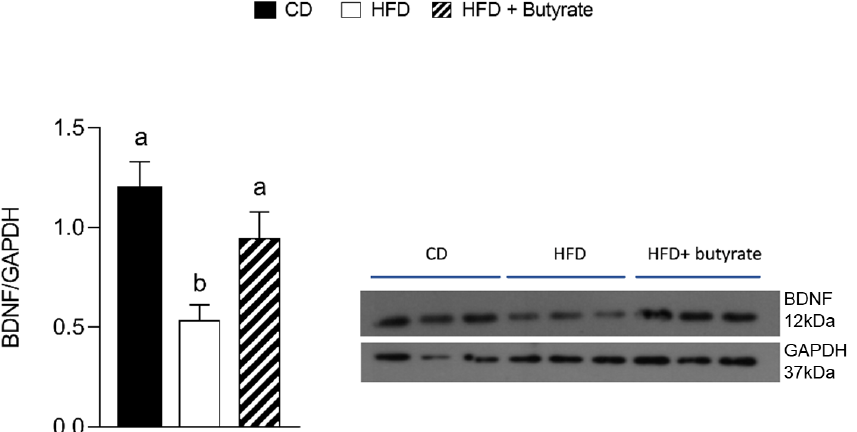
Figure 7. Effects of butyrate treatment on BDNF expression levels in the cerebral cortex of diet- induced obese mice. Expression level of BDNF was normalized with that of GADPH. Data are presented as means ± SEM from n = 3 animals/group. Different letters (a,b) on top of the bars indicate statistically significant differences ( p < 0.05) among groups.